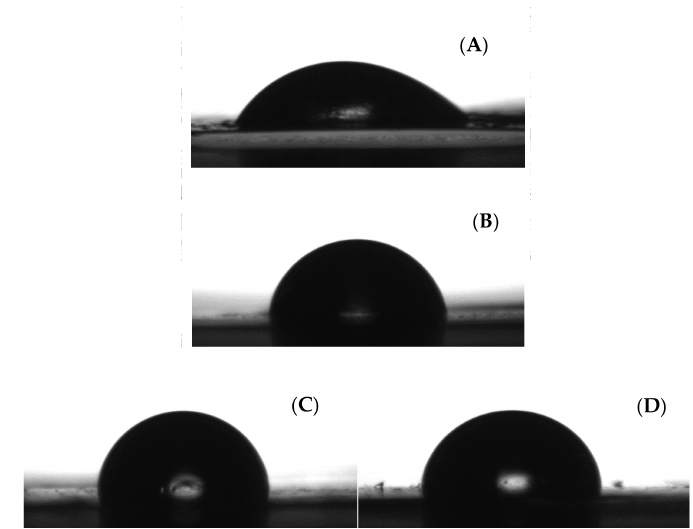
Figure 6. Images of water droplets in contact angle measurements of the GEL film ( A ); PCL film ( B ); multilayer systems PCL-GEL-PCL ( C ); and (PCL+OR)-GEL-(PCL+OR) ( D